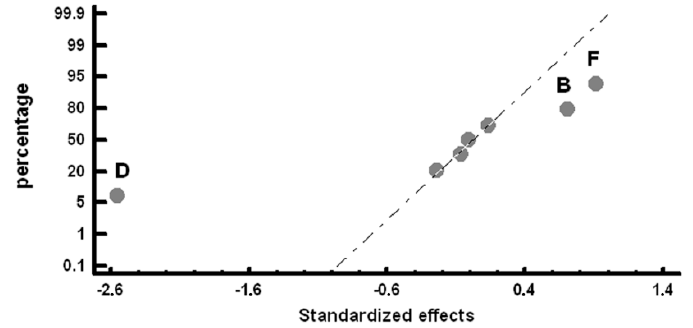
Figure 3. Standardized effects on the erosive wear, on a normal probability plot.